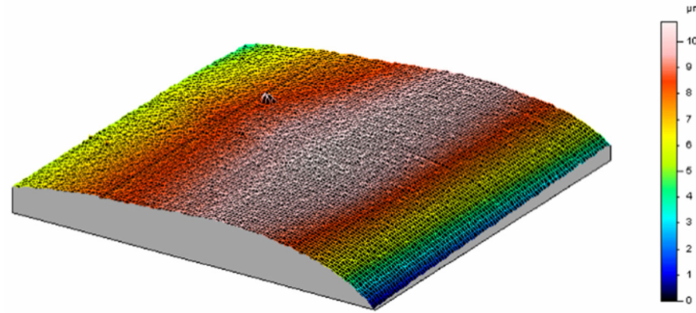
Figure 4. Surface roughness